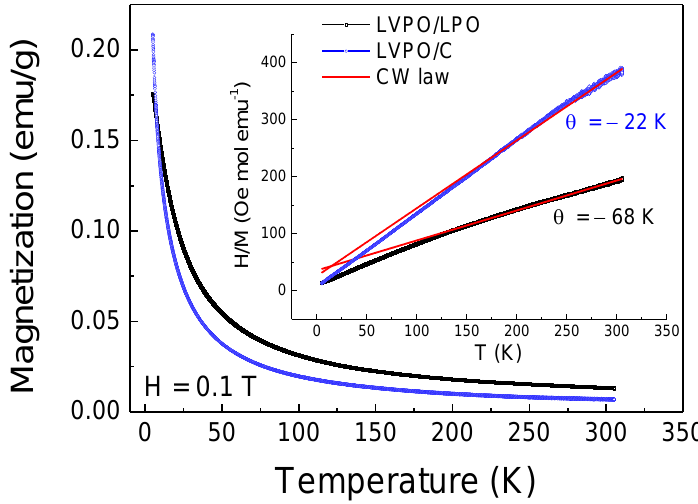
Figure 3. Temperature dependencies of magnetization M/H of the Li 3 V 2 (PO 4 ) 3 /Li 3 PO 4 sample in comparison with the Li 3 V 2 (PO 4 ) 3 /C powder sample measured in the FC regime in the external magnetic field H = 0.1 T. Inset shows the temperature dependence of the inverse magnetic susceptibility H/M; solid line corresponds to the Curie–Weiss law (see details in the text).